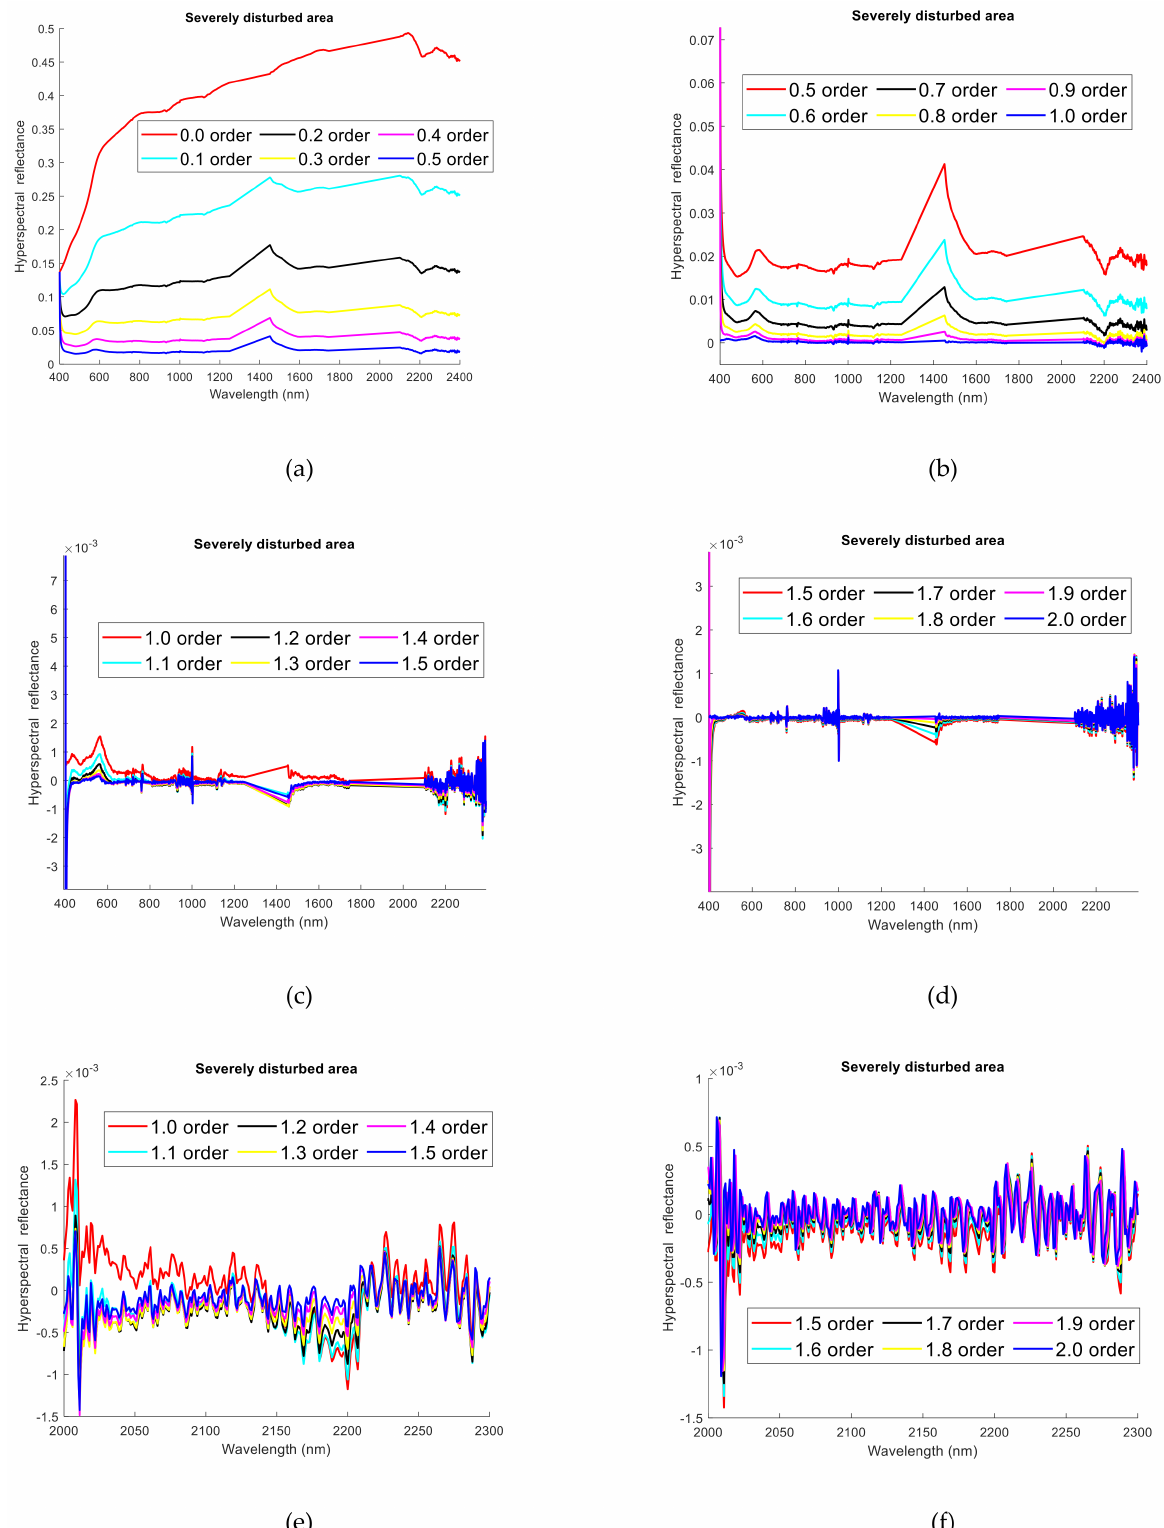
Figure 4. The reflectance curve of the soil original hyperspectral calculated by FOD in the severely disturbed area: ( a ) 0.0- order to 0.5-order; ( b ) 0.5-order to 1.0-order; ( c ) 1.0-order to 1.5-order; ( d ) 1.5-order to 2.0-order; ( e ) 1.0-order to 1.5-order of local amplification band; ( f ) 1.5-order to 2.0-order of local amplification